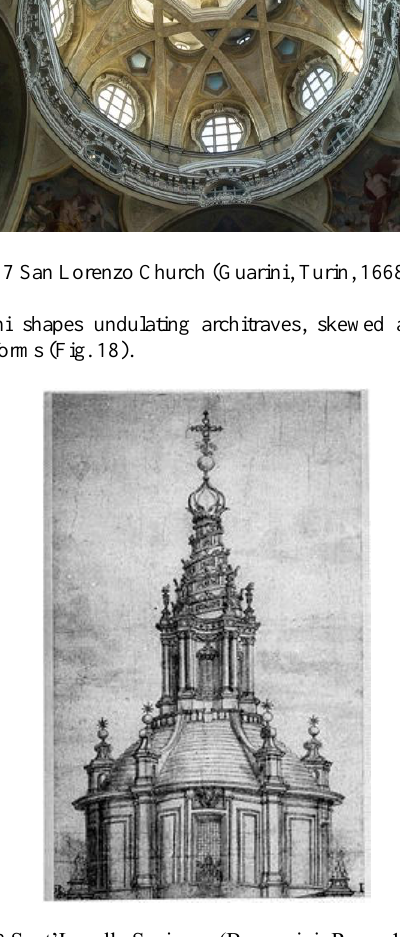
Fig. 18 Sant’Ivo alla Sapienza (Borromini, Rome 1642-62) The colonnade of Piazza San Pietro (by Bernini), which is straight to the eye of the observer at the center of the piazza, appears continuously transformed as the closer up he comes with the columns seemingly oblique (Fig.